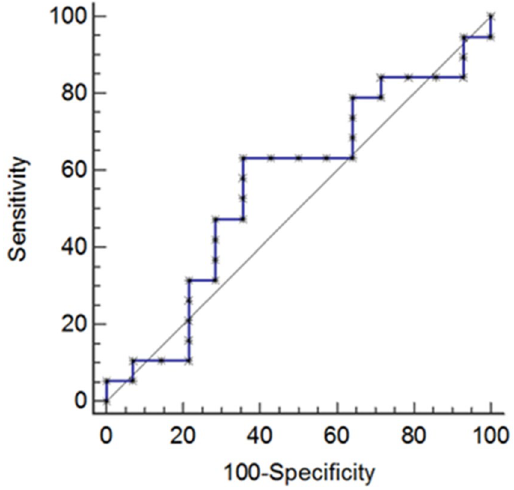
Figure 3. Prognostic value of the decrease in ECP serum concentrations between days 0 and 60. The prognostic properties of the decrease of ECP serum concentrations measured by means of ELISA between baseline and day 60 with respect of the occurrence of a clinical remission in patients with BP are depicted as a receiver operating characteristic (ROC)